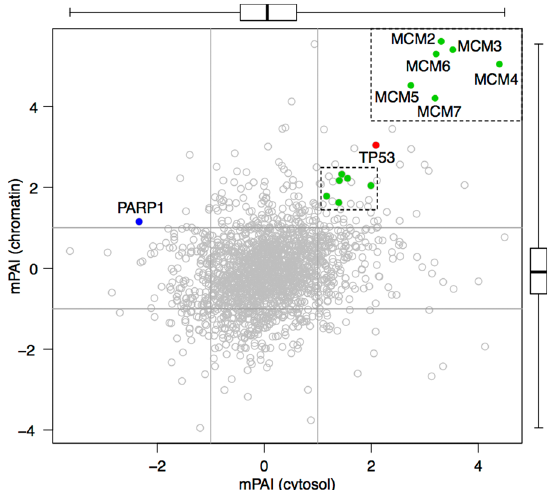
Fig. 4 A double-positive mtp53 association seen for all MCM2-7 complex proteins in cytosol ( x -axis) and nucleus ( y -axis). Each dot ( n = 1778) represents a protein with its position determined by its mPAI values in the cytosolic ( x -axis) and the chromatin fractionations ( y -axis). mPAI values were averaged if multiple peptides of the same protein were identi fi ed. Two side boxplots show the median, the lower and upper quartiles, and the range of mPAI values. The majority of points fall inside the x = − 1, x = 1, y = − 1, and y = 1 lines, indicating that abundance of most proteins are not signi fi cantly impacted by mtp53 knockdown in either fractionation. The mtp53 and the six members of the MCM2 – 7 complex fall in the top right quadrant, where protein levels are positively associated with mtp53 levels in both fractionations. PARP1 falls in the top left quadrant showing negative association with mtp53 in the cytosol but positive association in the nucleus, consistent with our previous experiment result. 6 A searchable, zoomable, and clickable scatter plot of mPAI values for 4798 genes and 1330 associated pathways and gene sets is available at http://diverge.hunter.cuny.edu/~weigang/mpai-browser/